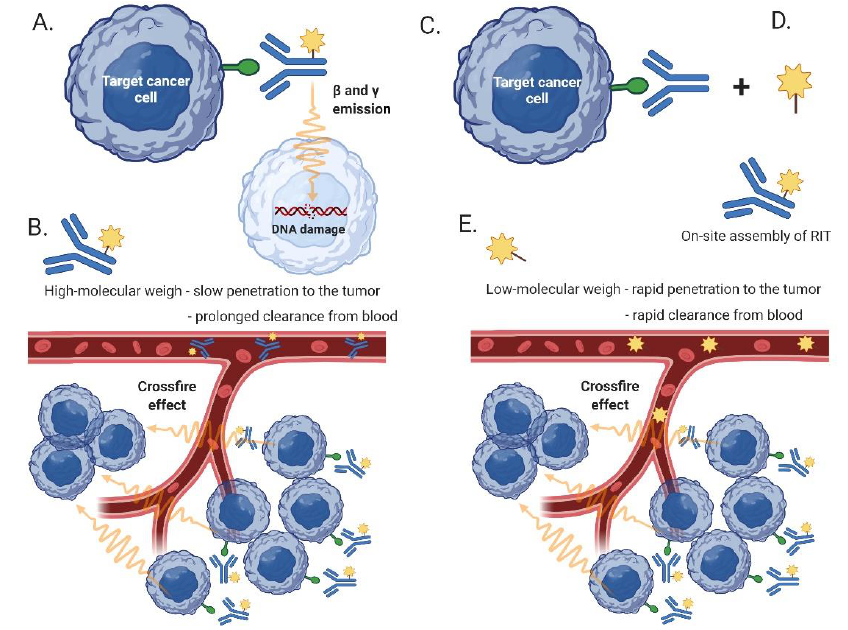
Figure 5. Mode of action of conventional and pretargeted radioimmunotherapy. ( A ) In conventional RIT, a radioimmunoconjugate binds directly to the tumor cells, but due to its high-molecular weight ( B ) it is slowly cleared from the bloodstream resulting in enhanced toxicity. ( C ) Compared to RIT, PRIT employs a targeting MAb as the first step, followed by the administration ( D ) of a small-molecular-weight radioconjugate that ( E ) rapidly penetrates to the tumor and that is rapidly cleared from the bloodstream, resulting in fewer off-target side effects. Created with BioRender 02 December